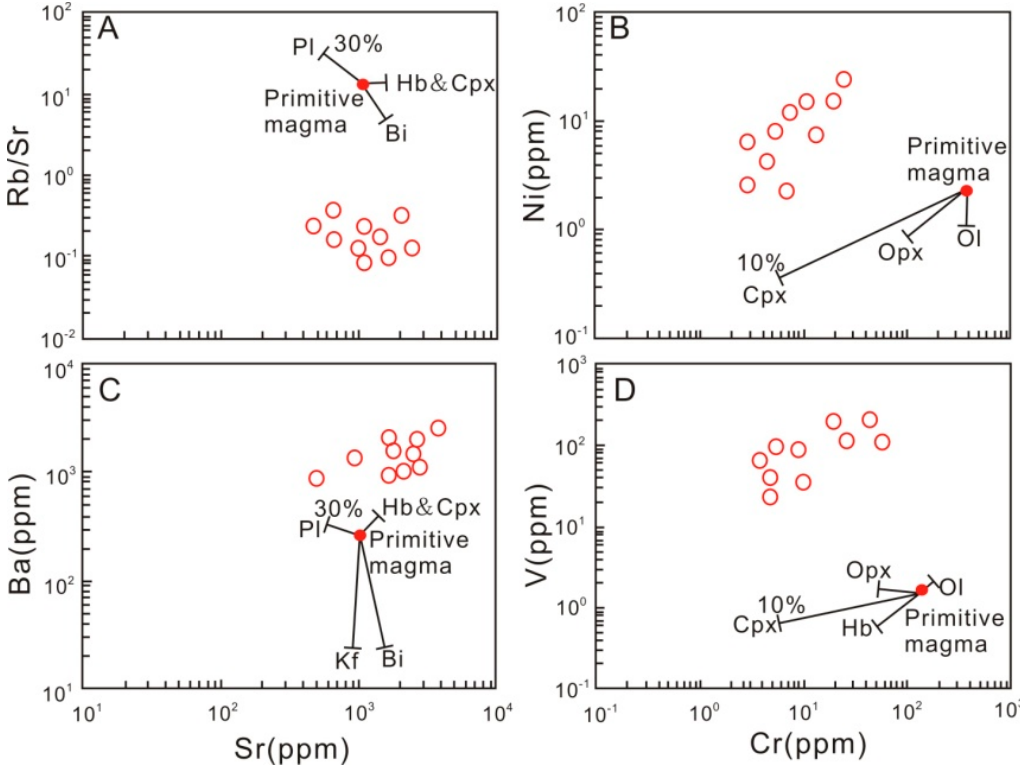
Figure 12. ( A ) Rb/Sr, and ( C ) Ba vs. Sr and ( B ) Ni and ( D ) V vs. Cr diagrams showing crystal fractionation trends. Note: hollow circlerepresents syenite samples. Solid circlerepresents intersection.